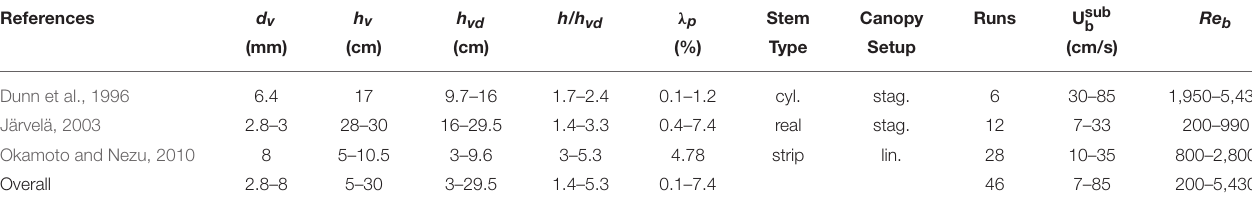
TABLE 4 | Overview of experimental studies on drag in submerged flexible canopies from which data was